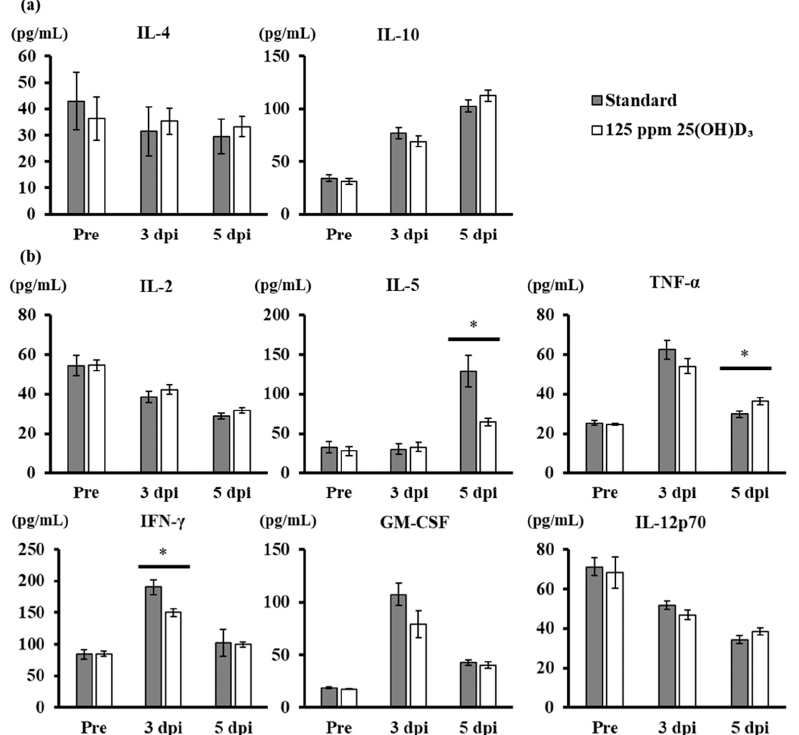
Figure 5. Levels of anti-inflammatory and proinflammatory cytokines before and after viral challenge ( n = 6 mice/group). Mice were fed a standard diet or a diet supplemented with 125 ppm 25(OH)D 3 for 7 weeks and then challenged with PR8 (H1N1) intranasally. ( a ) Concentrations of anti-inflammatory cytokines IL-4 and IL-10. ( b ) Concentrations of proinflammatory cytokines IL-2, IL-5, TNF- α , IFN- γ , GM-CSF, and IL-12p70. *, significant difference ( p < 0.05).